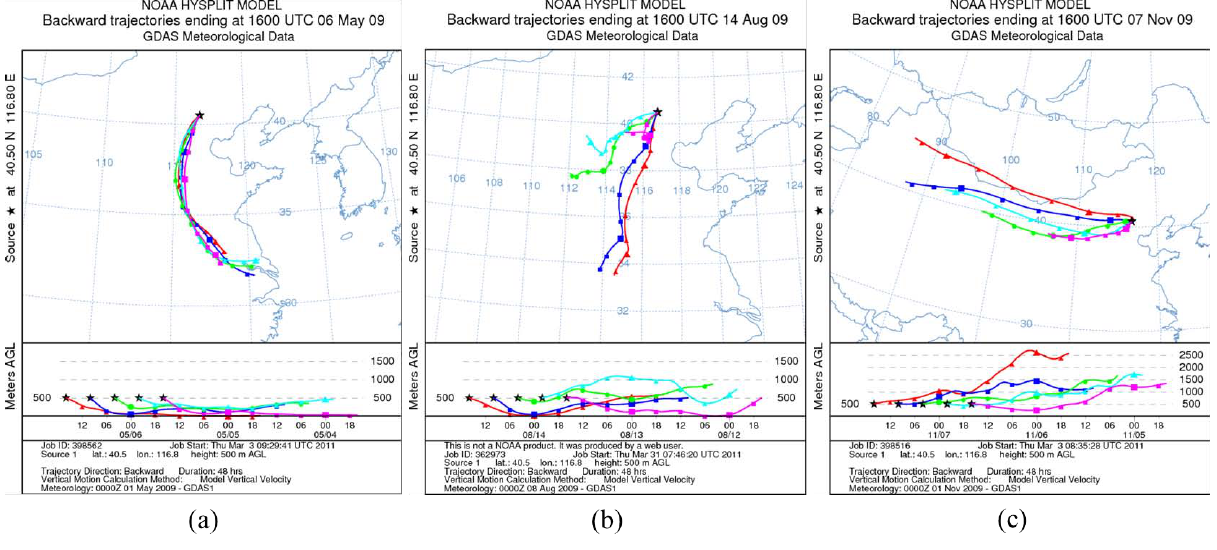
Fig. 10. HYSPLIT modeling results for the periods of (a) 4–6 May, (b) 12–14 August and (c) 5–7 November 2009.